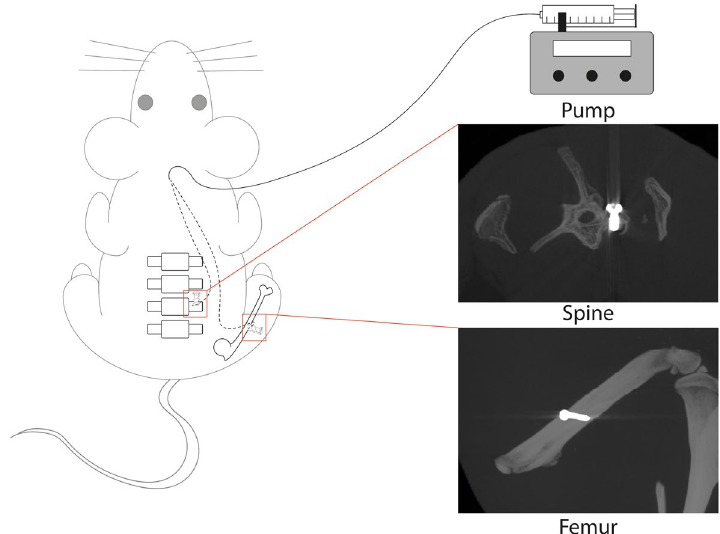
Fig. 1 Schematic representation of experimental setup. Screws with a catheter attached were implanted in either the spine or femur. Catheters were then tunneled subcutaneously (dotted line) and exited between the shoulders. A pump was connected to the catheter to allow controlled infusion of bupivacaine solutions. Representative MicroCT images for the two surgical locations are